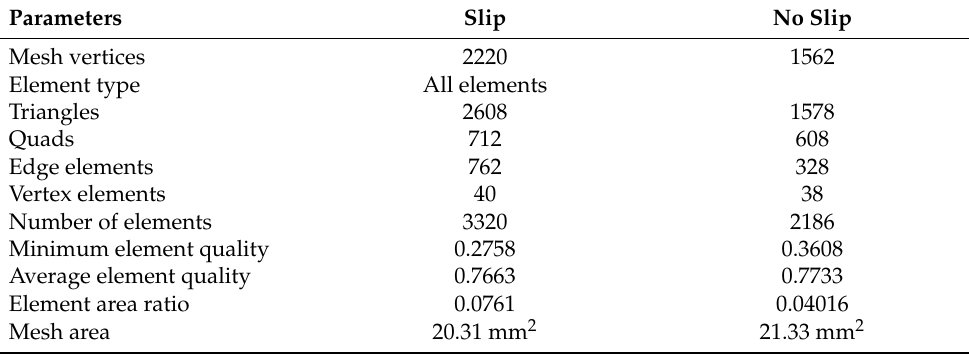
Table 1. Mesh statistics.